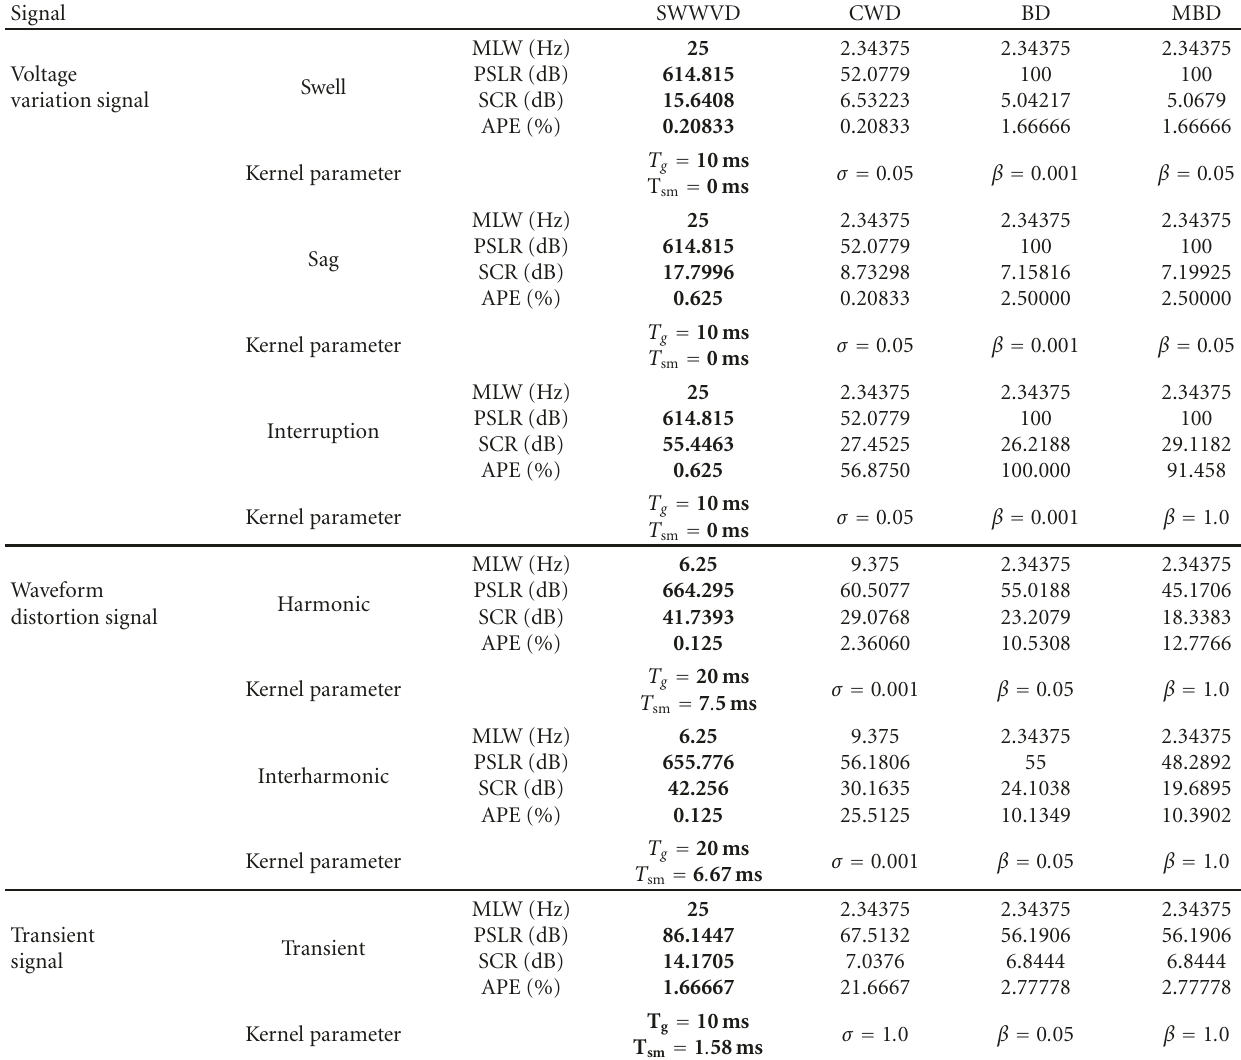
Table 7: Performance comparison between optimal kernel parameters for the